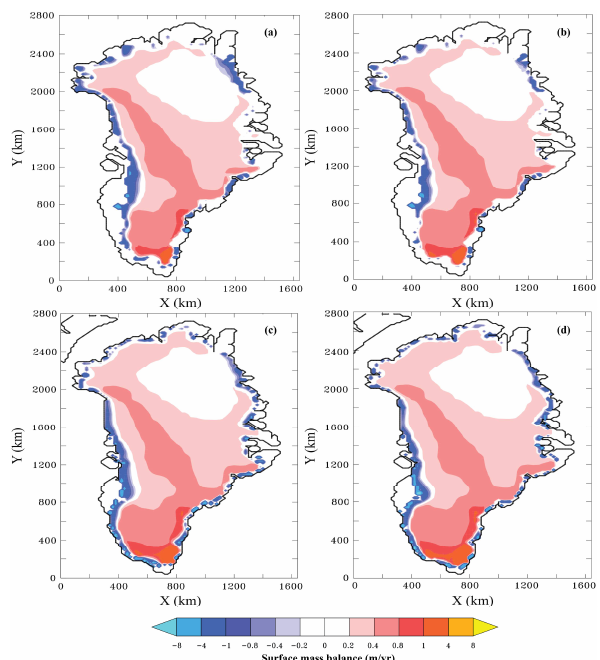
Figure 5. Sensitivity to different temperature forcings for the GrIS. The net surface 2 Fig. 5. Sensitivity to different temperature forcings for the GrIS. mass balance (in m/yr) over Greenland for a) after 1 year of model time forced with 3 The net surface mass balance (in m/yr) over Greenland for (a) after EISMINT-3 temperatures b) after 1 year of model time forced with Hanna modified 4 1 year of model time forced with EISMINT-3 temperatures (b) af- temperatures, c) after 50,000 years of model time forced with EISMINT-3 5 ter 1 year of model time forced with Hanna modified temperatures, temperatures and d) after 50,000 years of model time forced with Hanna modified 6 (c) after 50000 years of model time forced with EISMINT-3 tem- temperatures. Note the non-linearity of the scale. 7 peratures and (d) after 50000 years of model time forced with Hanna modified temperatures. Note the non-linearity of the